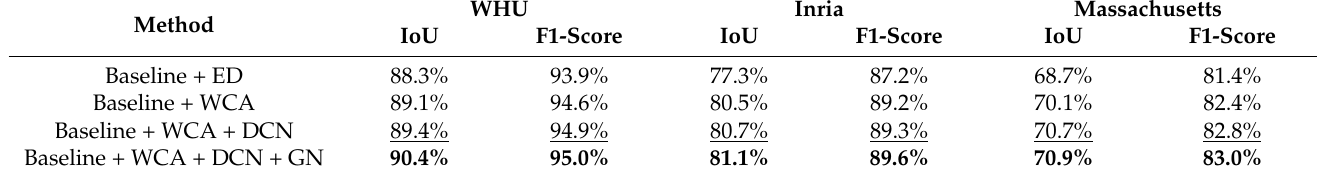
Table 9. Ablation experimental results obtained on the three datasets. The highest scores are bolded; the second-highest scores are underlined.